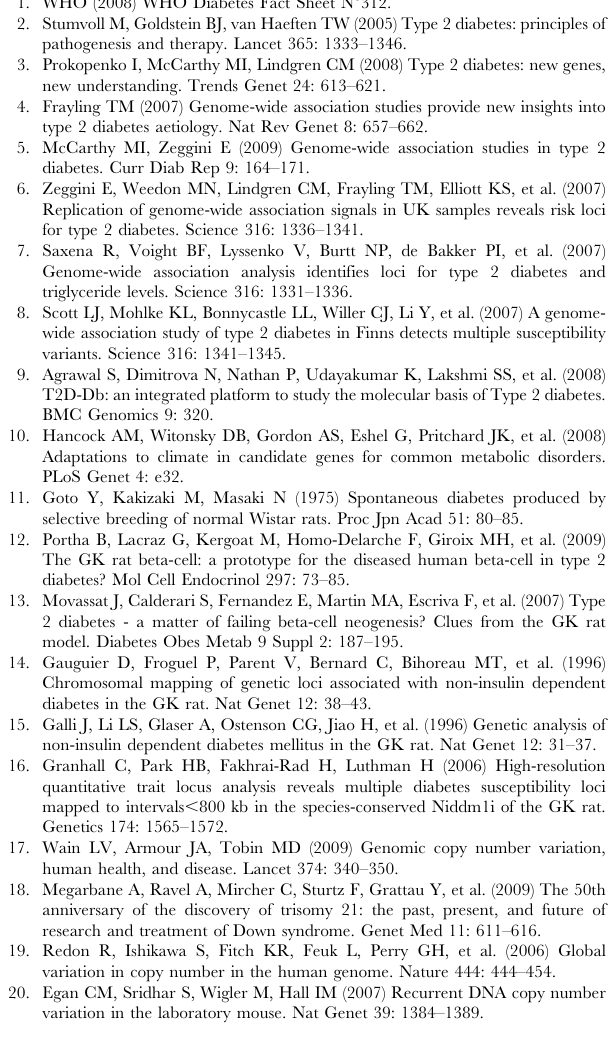
Table S10 Pathway mapping and enrichment of the targets of rno-mir-30b.